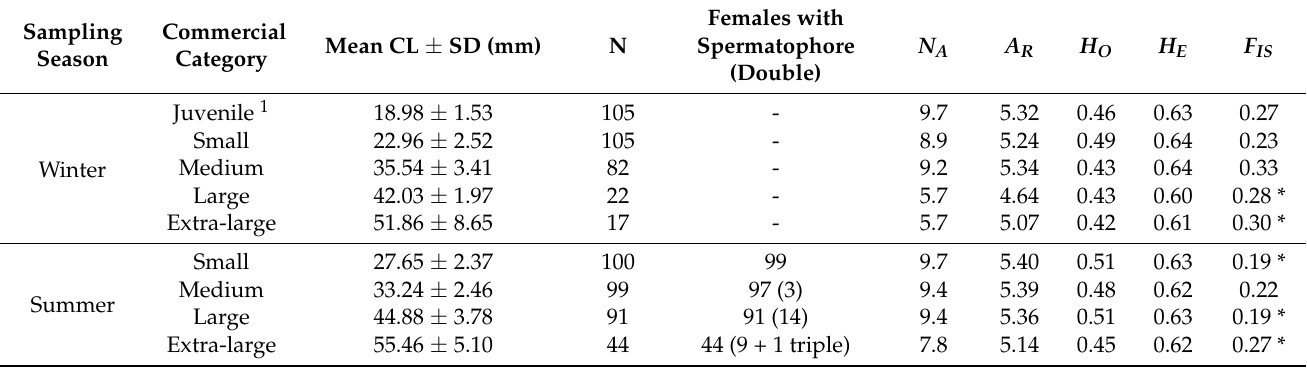
Table 1. Commercial size groups of Aristeus antennatus ( A. antennatus ) females, including sampling season, commercial category, mean carapace length (CL) with standard deviation (SD), number of females (N), number of females with one or more spermatophores adhered to the thelycum, and estimates of genetic diversity (excluding locus Aa818